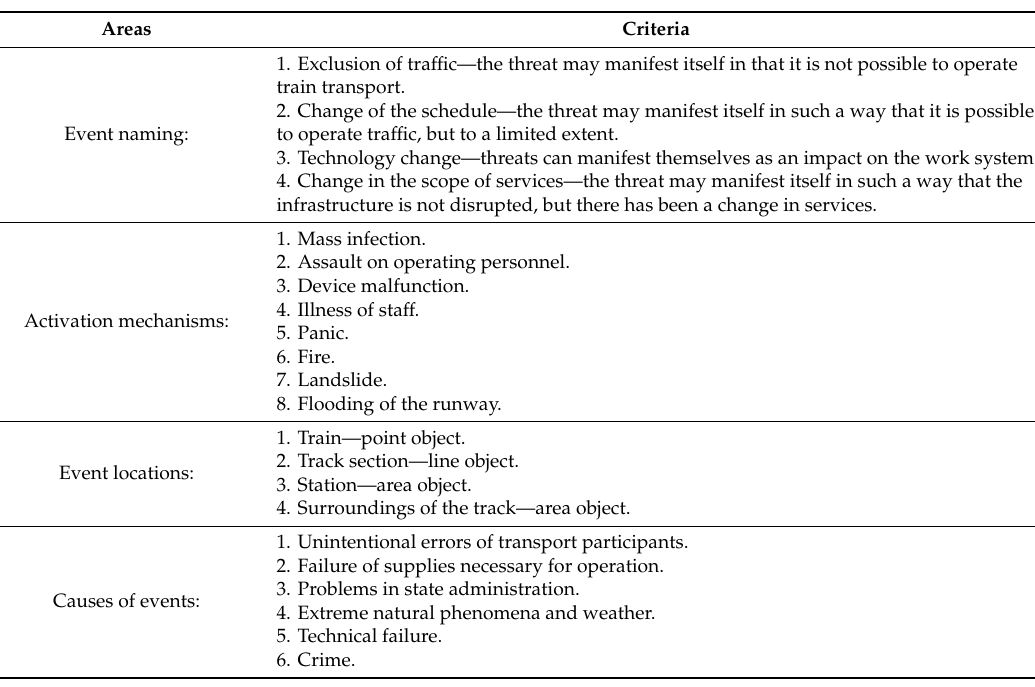
Table 1. Criteria determining the type of